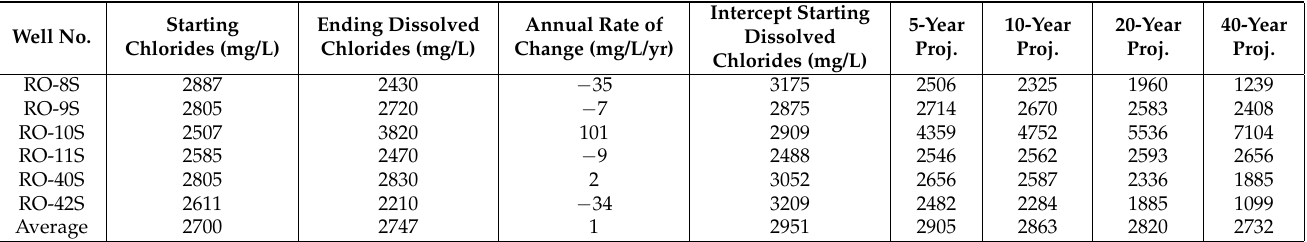
Table 5. Lower Hawthorn Aquifer starting and ending dissolved chloride concentrations with 5, 10, 20, and 40-year